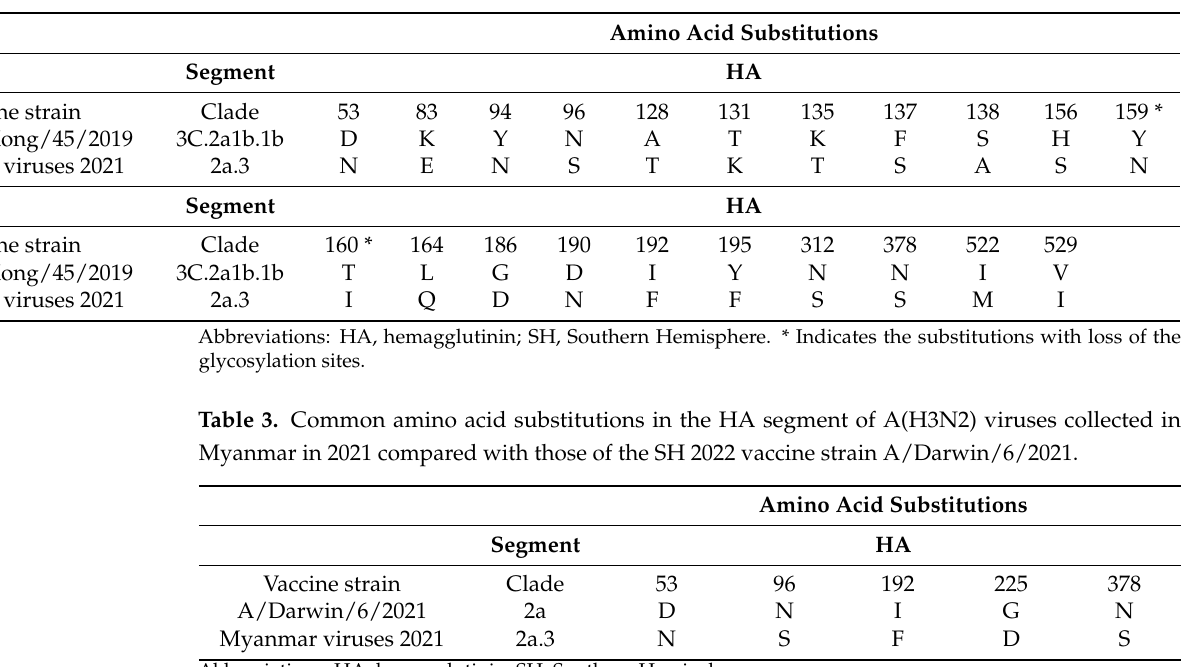
Table 2. Common amino acid substitutions found in the HA segment of A(H3N2) viruses collected in Myanmar in 2021 compared with those of the SH 2021 vaccine strain A/Hong Kong/45/2019.